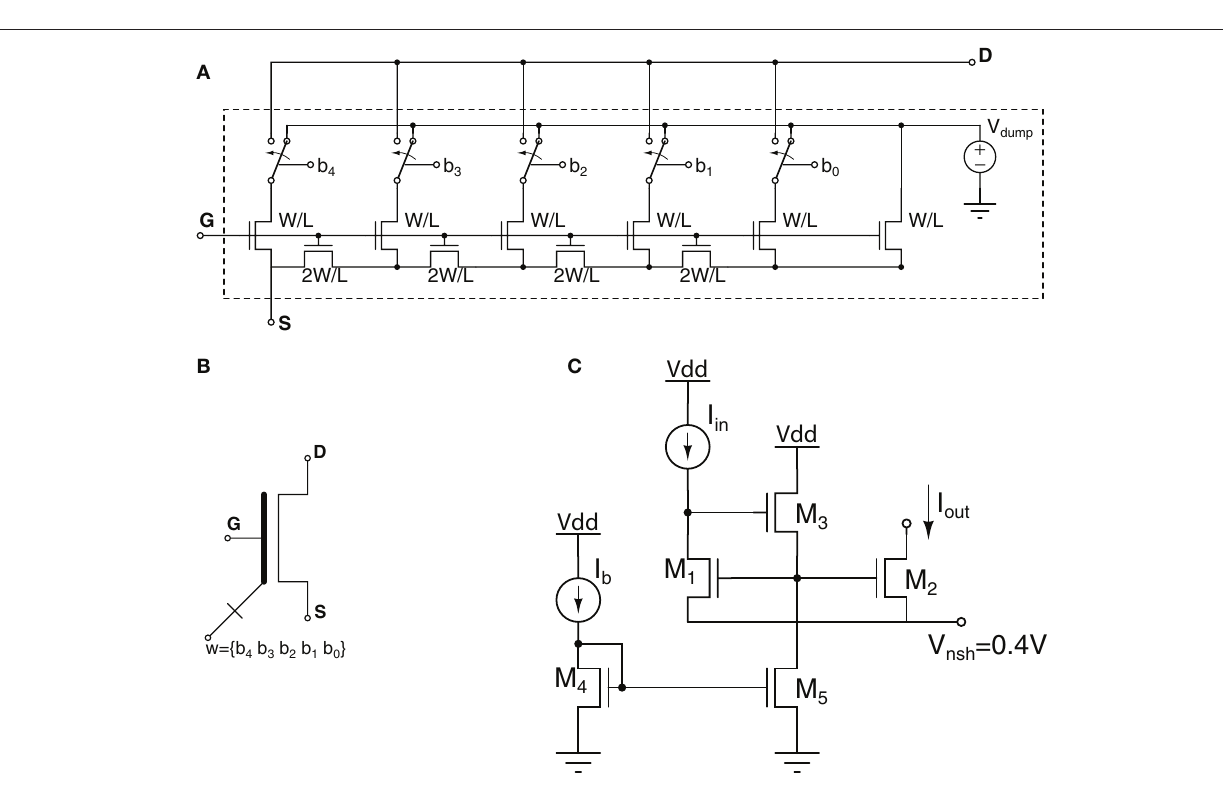
. Example five-bit implementation using MOS ladder techniques (b) Digi-MOS eff